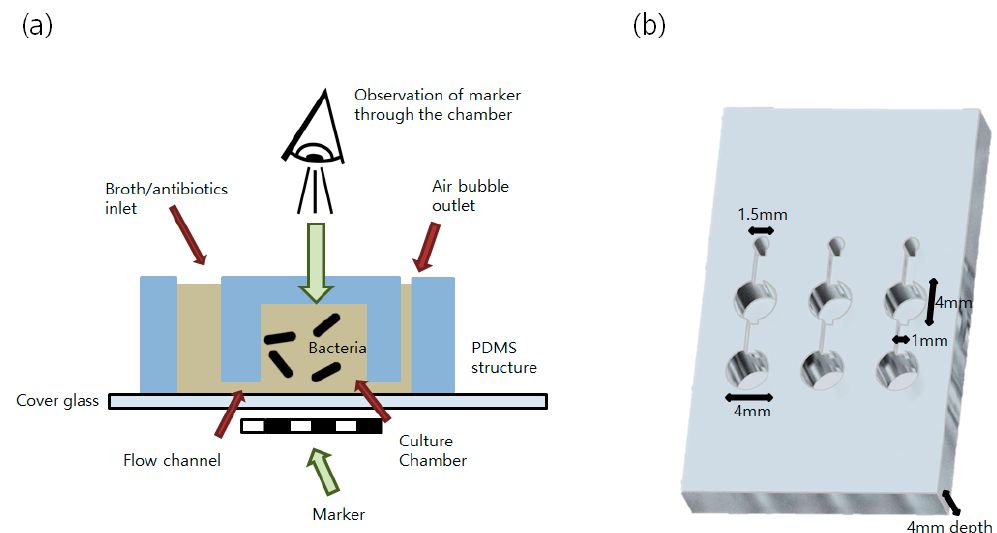
Figure 3. Schematic drawing of the designed polydimethylsiloxane (PDMS) devices. Cross-sectional diagram ( a ) and 3D view ( b ) of the designed PDMS device for observing bacterial growth is shown. The device was fabricated by using a modified protocol proposed by Shin et al.